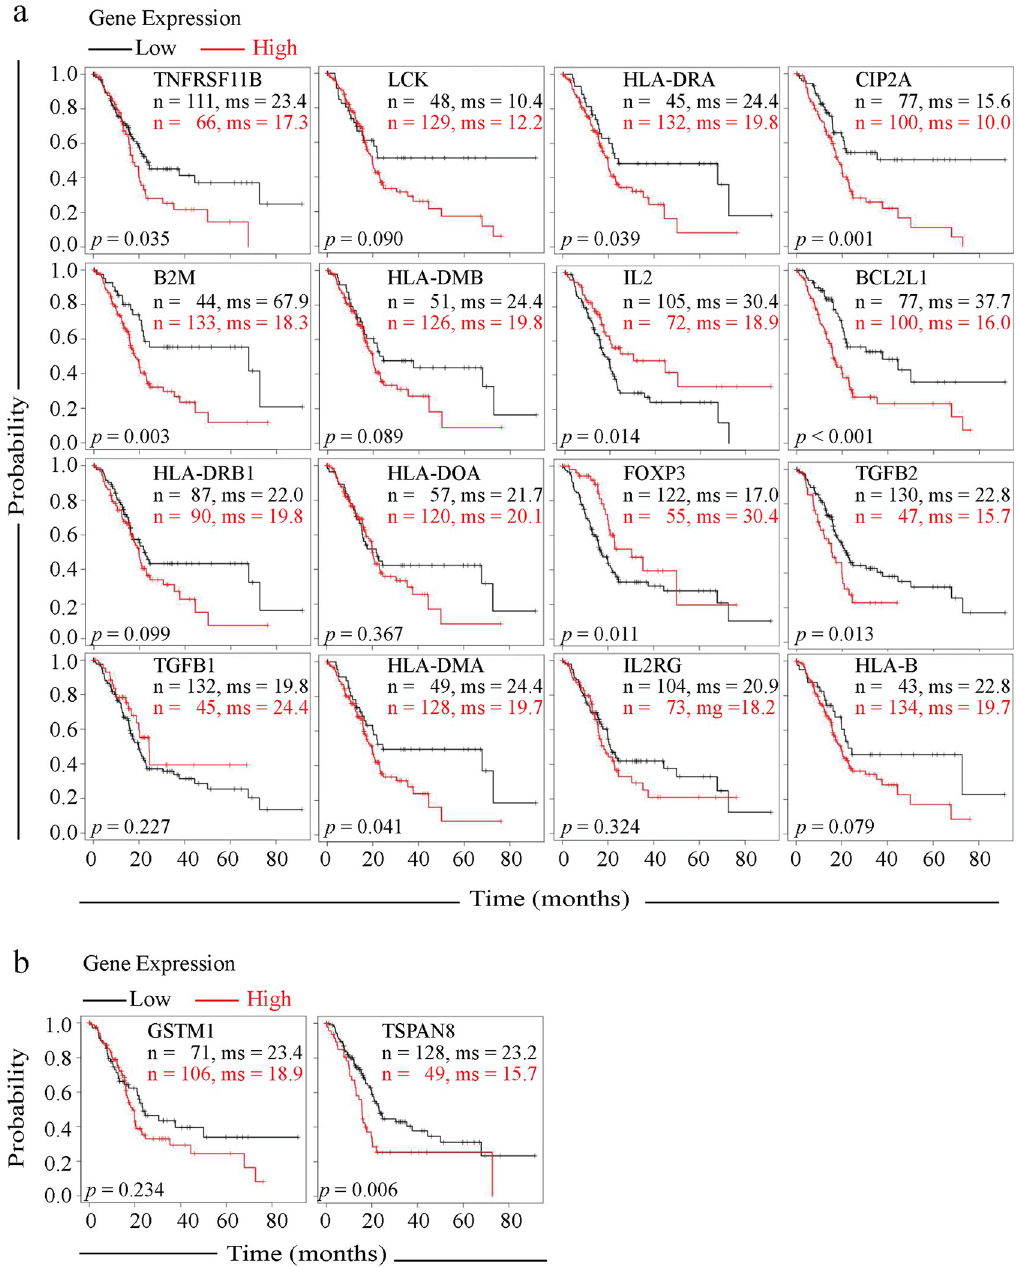
Fig 5. Gene expression level association with pancreatic cancer patient overall survival for 10 years. Kaplan-Meier plots of PD1 pathway gene expression difference between Black and White patients (a) and the race-associated and tumor specific GSTM1 and TSPAN8 genes from Black patients (b). The overall sample size (n) was 177. The median survival (ms) time in months and the log-ranked p value are provided for each analysis.